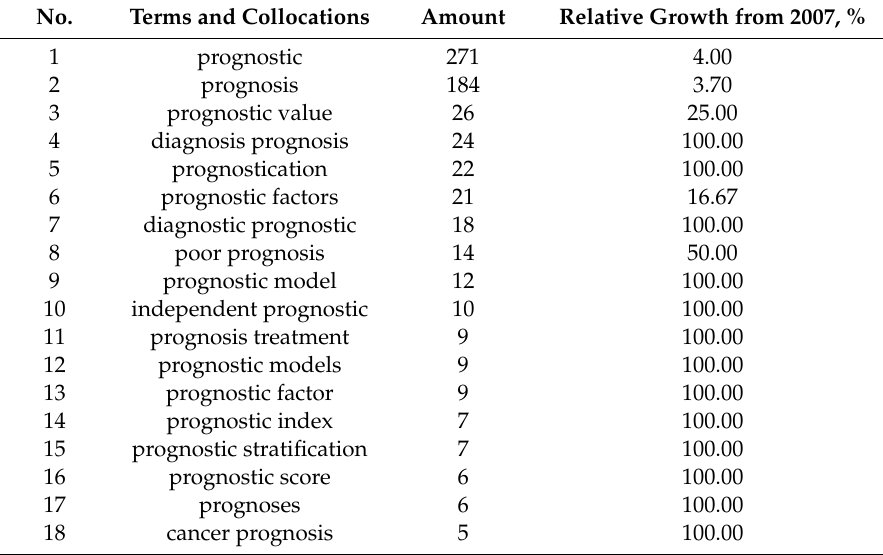
Table 5. Terms and collocations with “prognosis” as the root word (red color in cyberspace). No. Terms and Collocations Amount Relative Growth from 2007, % 1 prognostic 271